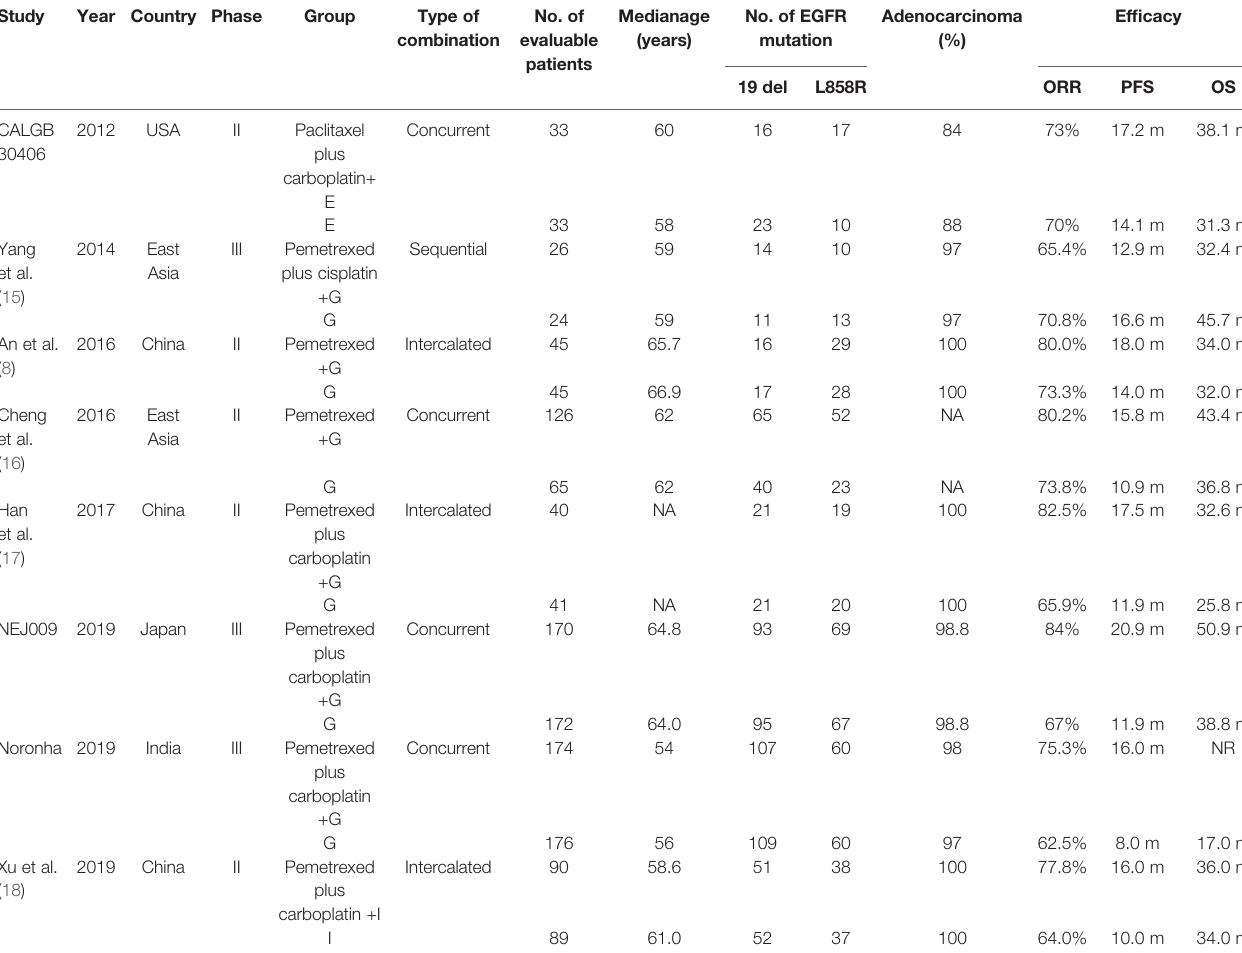
TABLE 1 | Characteristics of the included randomized trials in the meta-analysis. Study Year Country